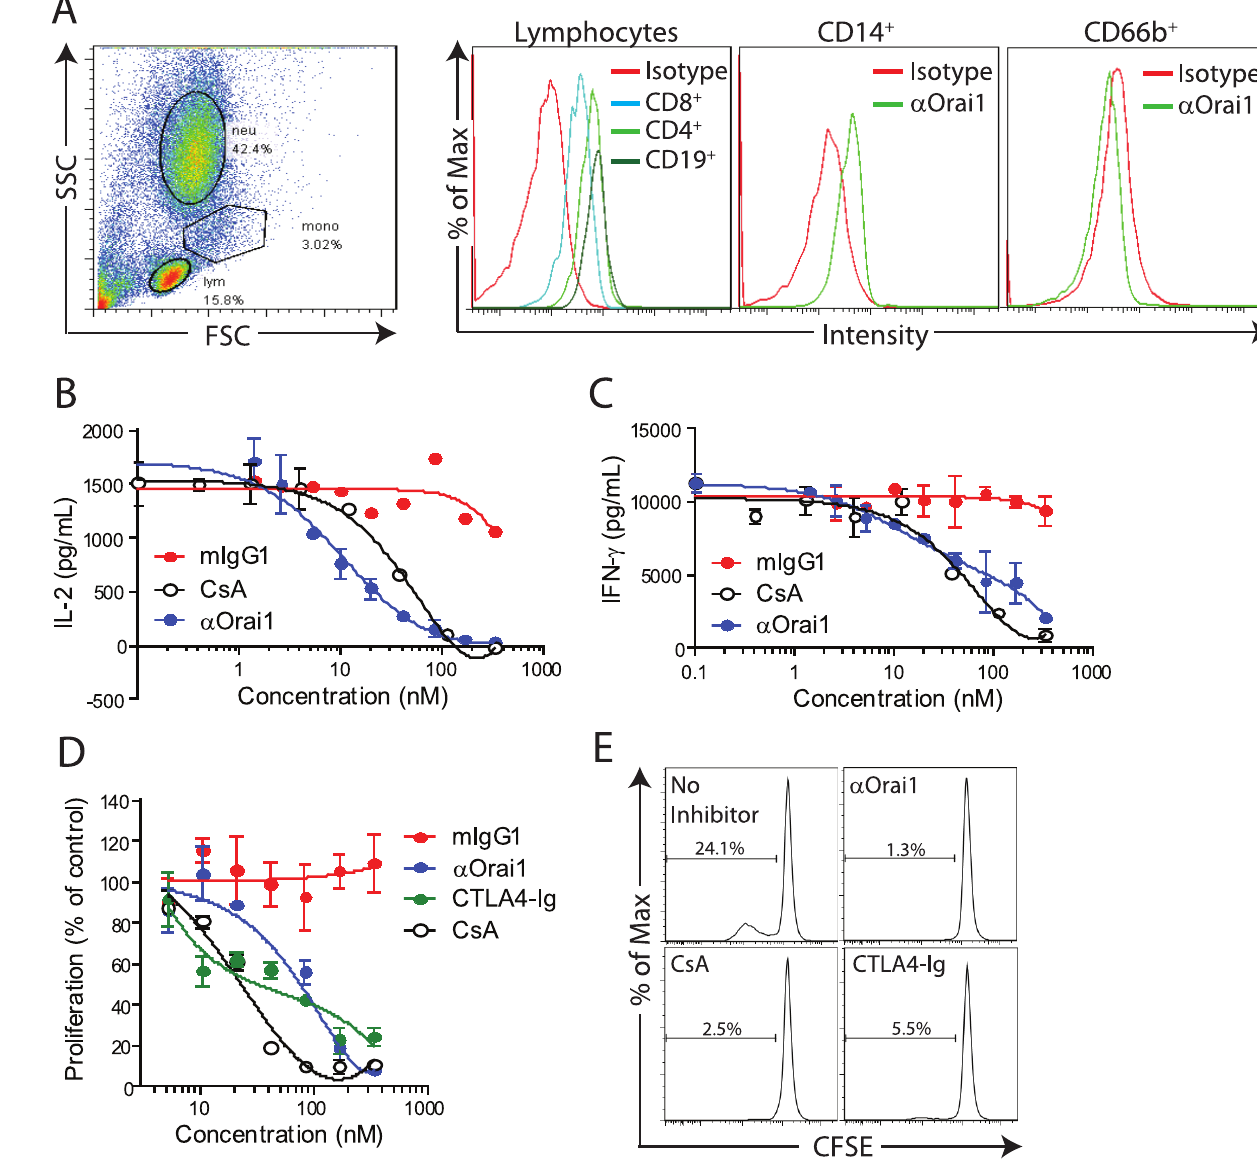
Figure 6. Anti-Orai1 reduces cytokine production by RA synovial fluid cells. A ) Representative forward and side scatter of synovial fluid cells (SFCs) with gating of lymphocytes (lym), monocytes (mono), and neutrophils (neut) and surface staining of Orai1 on CD4 + , CD8 + , and CD19 + lymphocytes, CD14 + monocytes, and CD66b + neutrophils from RA synovial fluid. B ) IL-2 and C ) IFN- c secretion from a CD3/ a CD28 costimulated SFCs following 40 hour-culture in the presence of mIgG1 isotype control, a Orai1, or cyclosporine A (CsA). D ) Proliferation of RA patient PBMCs treated with SEB in the presence of control mIgG1, anti-Orai1, CTLA4-Ig, or cyclosporine A (CsA). Data is calculated as percentage of CFSE-diluted cells in the absence of inhibitor. E ) Representative CFSE dilution traces of SEB-induced proliferation of RA PBMCs in the presence of 333 nM inhibitor. All panels are representative of two independent experiments. doi:10.1371/journal.pone.0082944.g006 (Fig. 3C, 3D). Together, these data support the use of 10F8 for